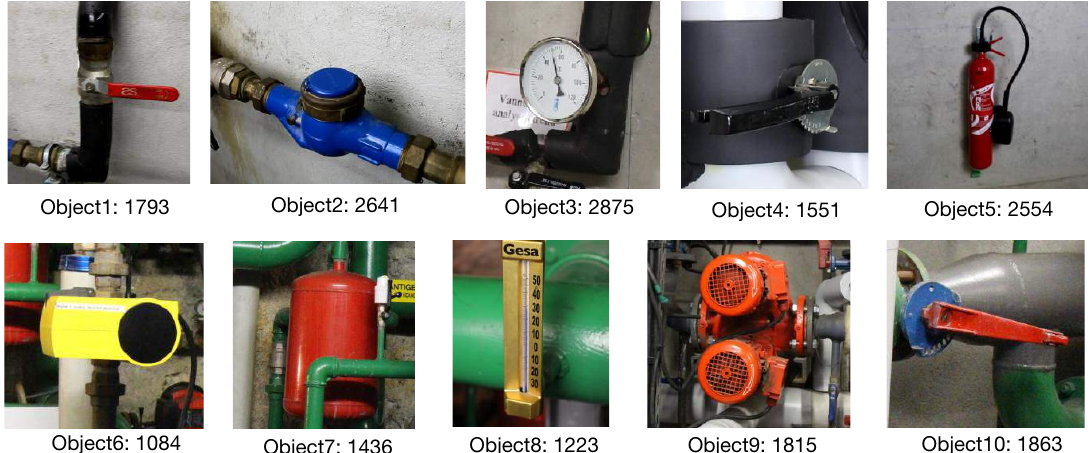
Figure 9. Sample images of 10 objects in industrial